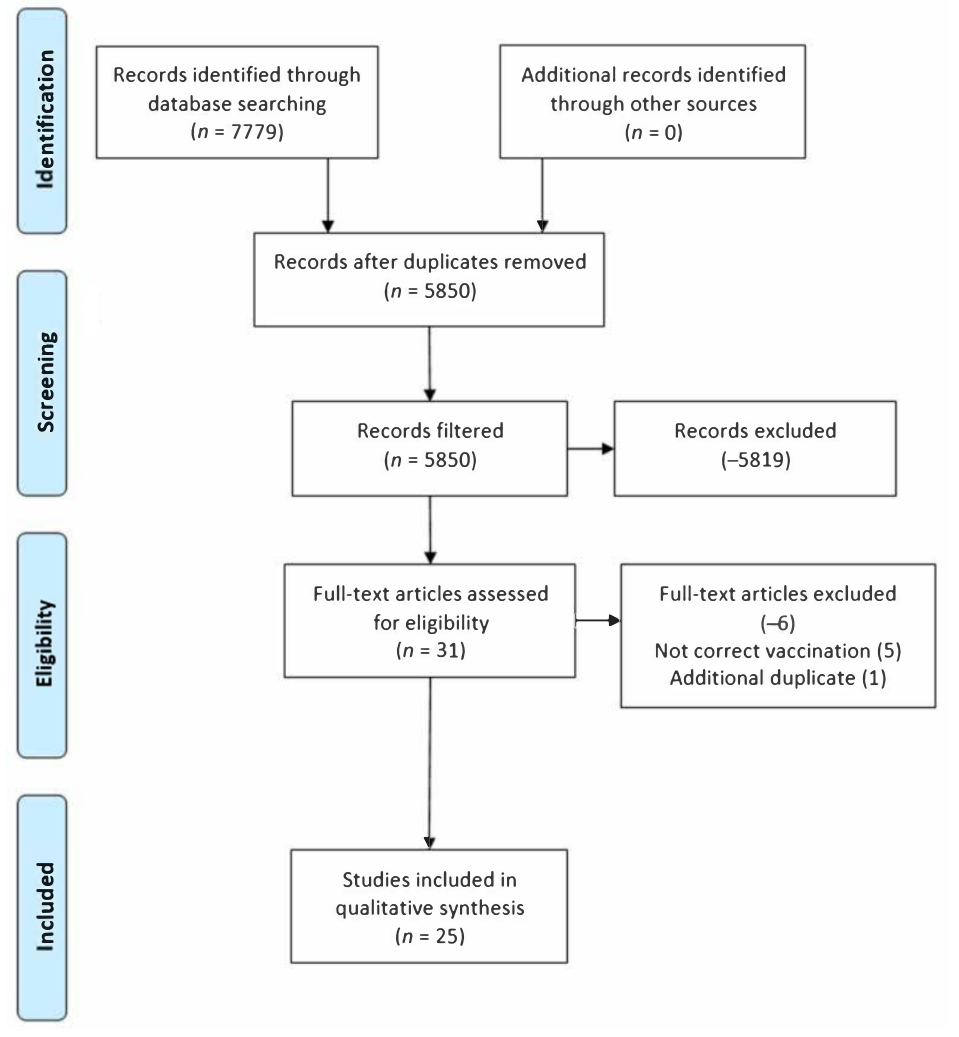
Figure 2. Preferred reporting items for systematic reviews and meta-analysis (PRISMA) figure that demonstrates the study selection process. Table 1. Reviewer assignment of the initial database search findings (full article